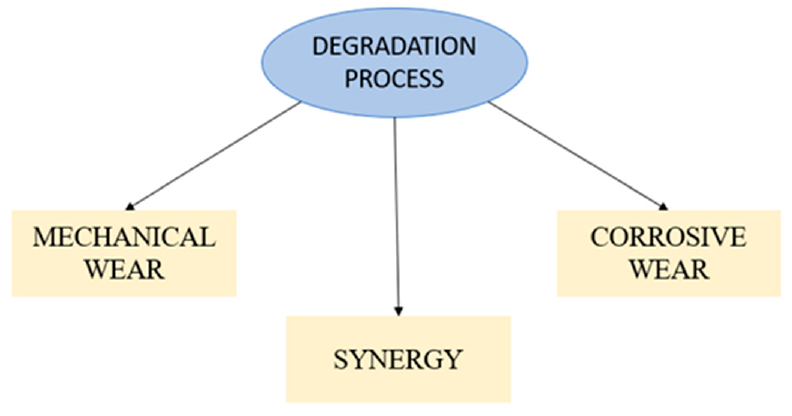
Figure 1. Schematic of tribocorrosion phenomena.